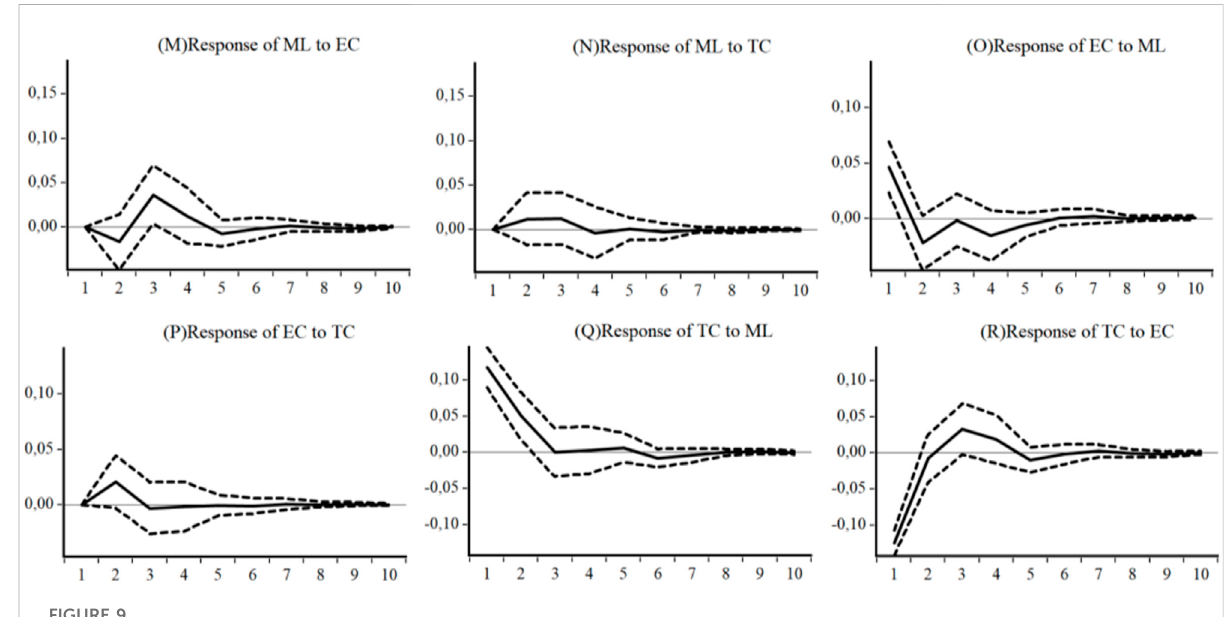
FIGURE 9 Impulse responses of ML , EC , and TC , central region. (M) Response of ML to EC, (N) Response of ML to TC, (O) Response of EC to ML, (P) Response of EC to TC, (Q) Response of TC to ML, (R) Response of TC to EC.